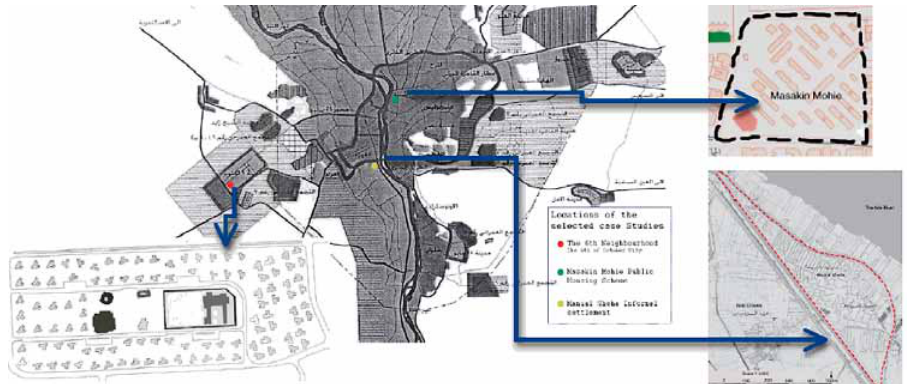
fig. 2. The locations of the selected case studies in the Greater Cairo region (prepared by the author according to a map obtained from Ministry of Housing, utilities and urban Communities, 2011: